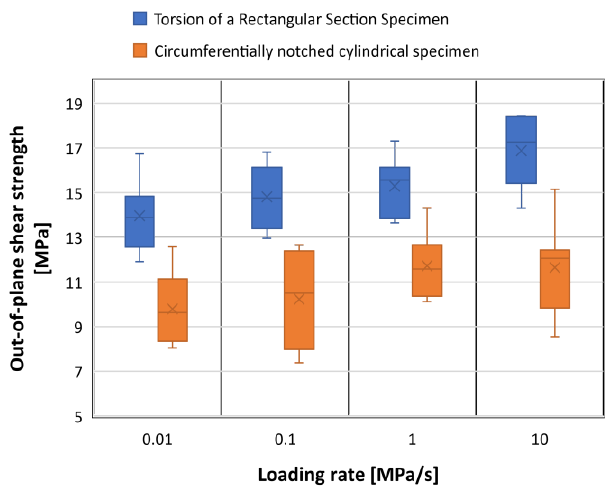
Figure 13. Comparison of the out-of-plane shear strength between the torsion test of rectangular section specimens and the circumferentially notched cylindrical specimen test.